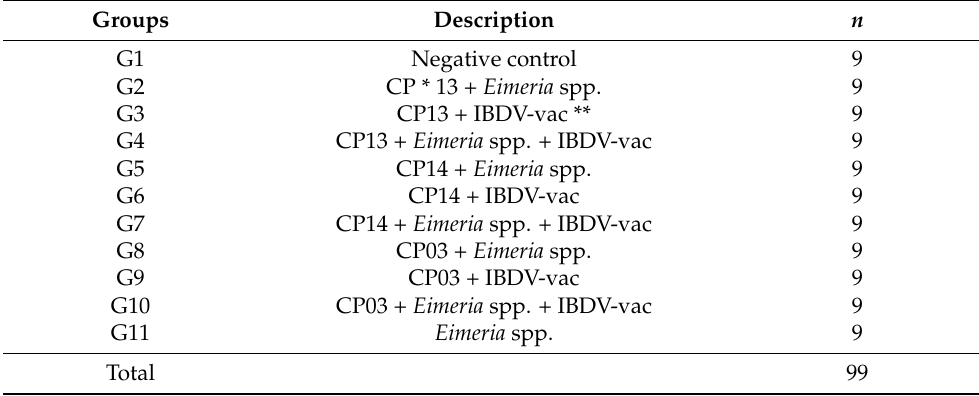
Table 1. Description of experimental groups.